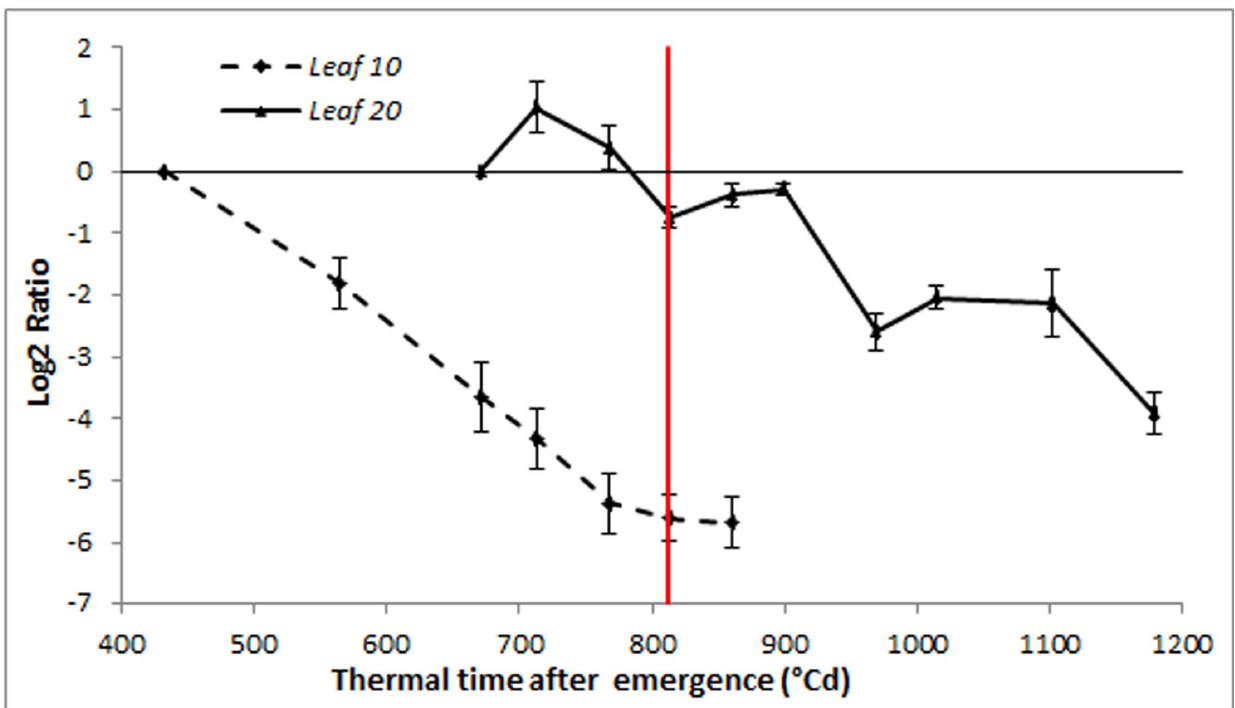
Figure 6. Ha-CAB2 expression profile. Relative values of Ha-CAB2 transcript levels referred to first sampling point, determined by qPCR (leaf 10 and 20) ( Ha-EF1 a as RG). The red line indicates anthesis time. Error bars correspond to standard errors.